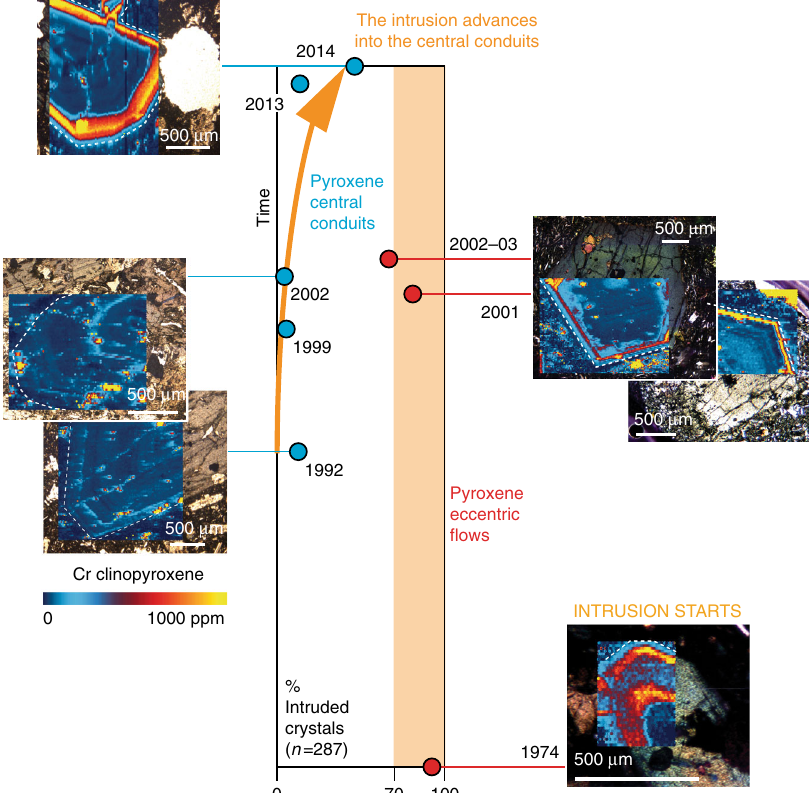
Fig. 3 Timeline of intrusion of Mt. Etna plumbing system with primitive magma recognised as zones enriched up to 10 3 ppm Cr in clinopyroxene crystals. In eccentric eruptions (red circles; right column), at least ~70% of crystals record magma intrusion. In central conduit eruptions (blue circles; left column), intrusion was minor in the 1990s and 2000s but is increasing in the present decade, correlating with the increase in eruptive activity. ‘ Intruded crystals ’ include antecrysts with Cr-rich rims and phenocrysts with Cr-rich cores (Supplementary Table 4; Supplementary Data